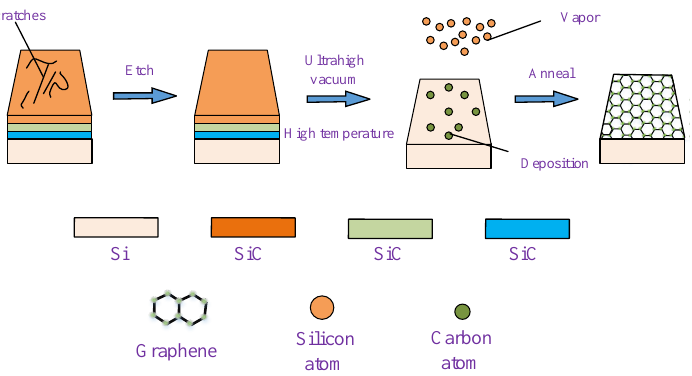
Figure 3. Mechanism of epitaxial growth of graphene. Table 2. A summary of epitaxial growth method and the properties of the synthesized graphene.